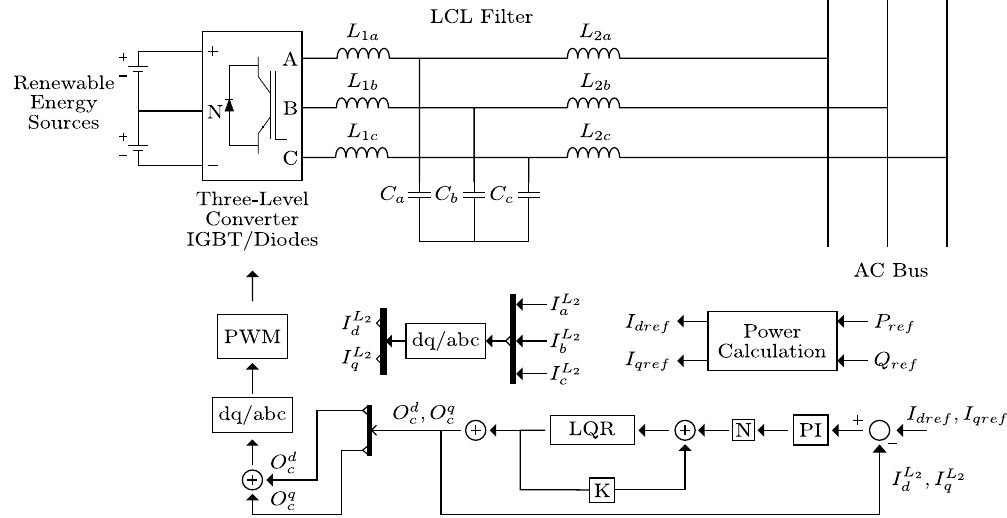
Figure 6. Optimal control scheme of a three-level converter in compensation